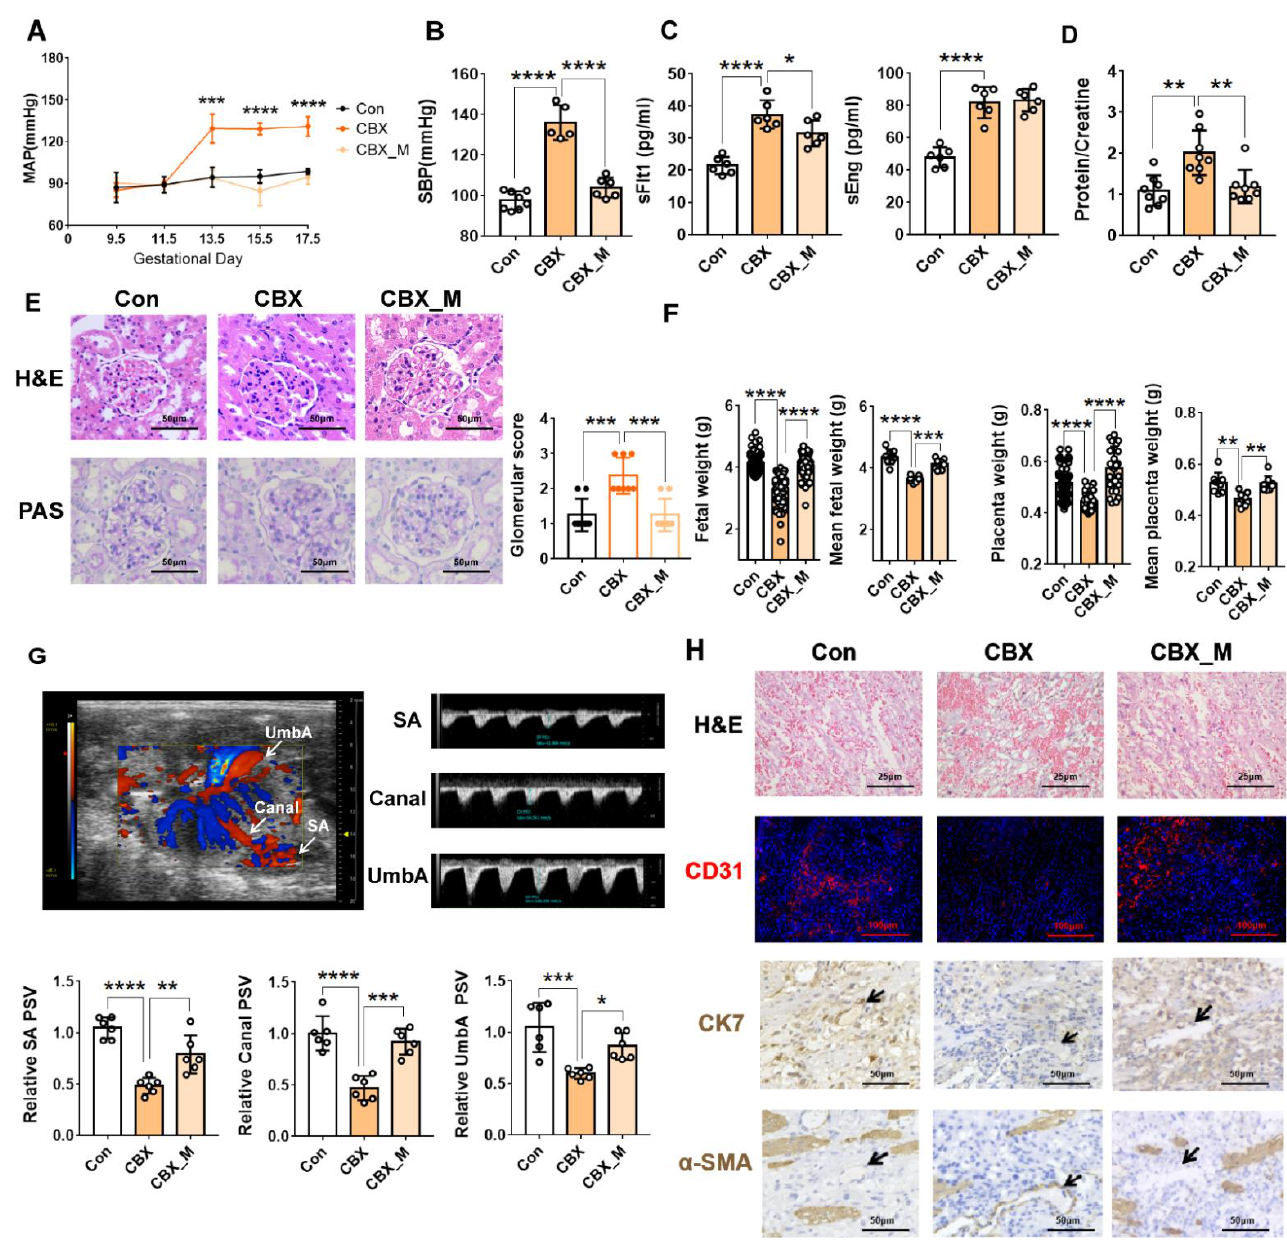
Figure 3. MitoTEMPO alleviates PE-like feature and improves placental blood flow and placentation in PE-like model. Pregnant rats were administrated with CBX, CBX combined with mitoTEMPO or saline from GD 7.5 to GD 17.5. Urine was collected from GD 18.5 to GD 19.5. After determination of arterial BP, the rats were sacrificed on GD 20.5 for collection of blood and tissues. ( A ) MAP measured from GD 9.5 until GD 17.5. ( B ) SBP measured on GD 20.5. ( C ) the circulatory sFlt1 and sEng levels in the rat model. ( D ) protein/creatinine (mg/mg) in urine in the rat model. ( E ) morphology of glomeruli stained by H&E and PAS. Left panel : the representative images (400×). Right panel : histopathological score of glomerular pathology. ( F ) fetal and placental weight from 8 dams (each group) measured on GD 20.5. It represents as individual fetal or placental weight and mean fetal and placental weight from each dam. ( G ) Doppler ultrasonography. Upper panel : the representative images of SA in implantation sites, canal in placentas and fetal UmbA visualized by ultrasound biomicroscopy. Lower panel : cumulative data of the PSV of SA, Canal and UmbA. ( H ) placental morphology, placental vasculature network and SP remodeling in the rat model. Repre- sentative H&E images of labyrinth zone (400×), representative immunofluorescence image of CD31 (100×), repr esentative image of CK7 staining in SA, and representative image of α -SMA staining in SA (200×). * p < 0.05, ** p < 0.01, *** p < 0.001, **** p < 0.0001. Con: control; CBX_M: CBX combined with mitoTEMPO treatment.